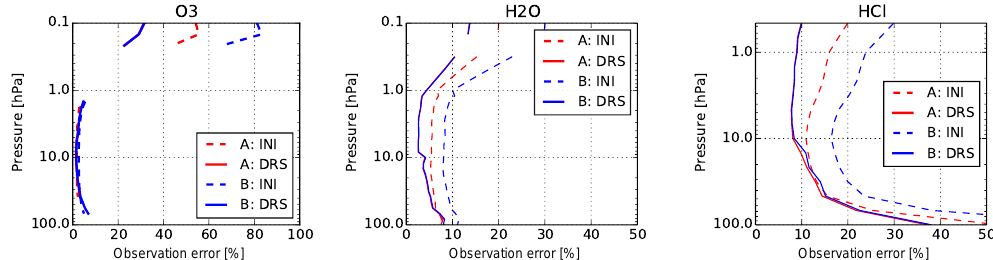
Figure 2. Initial (INI) observation error covariance matrix of experiment A (dashed red), starting with R = (σ o ) 2 , and B (dashed blue), starting with R = ( 1 . 5 σ o ) 2 and their Desroziers (DRS) estimations (solid red and blue lines, respectively), using statistics of the first 24h. The statistics is shown for O 3 , H 2 O and HCl.